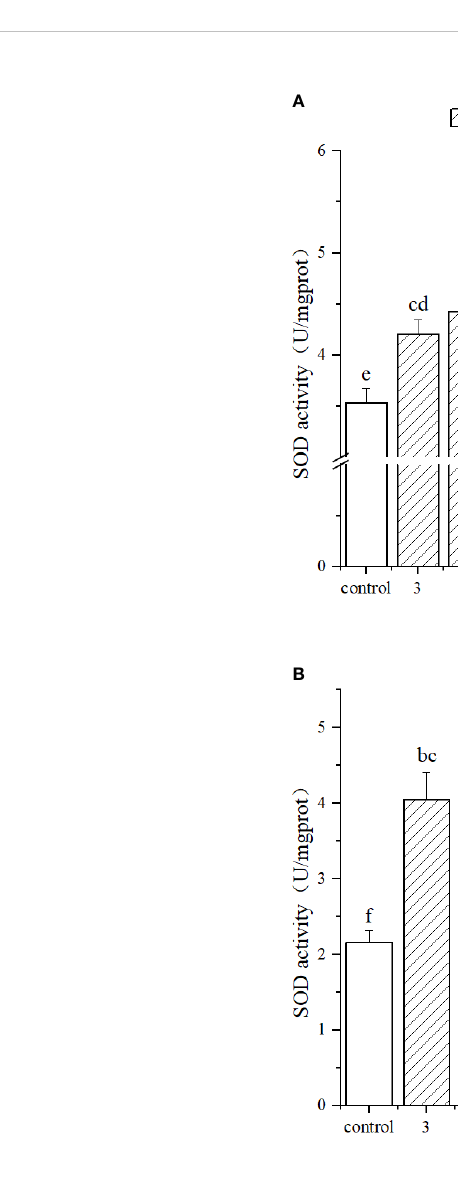
FIGURE 1 Superoxide dismutase (SOD) activity in the hepatopancreas tissue of Cyclina sinensis under long-term ammonia. (A) SOD activity in C sinensis exposed to long-term ammonia. (B) SOD activity in C sinensis infected with Vibrio parahaemolyticus . The control group in (A) comprised clams raised in natural seawater. The control group in (B) included clams raised in natural seawater without the addition of V. parahaemolyticus . The same lowercase letters indicate non-signi fi cant differences between the different stress time points ( p > 0.05); otherwise, the difference is signi fi cant ( p <